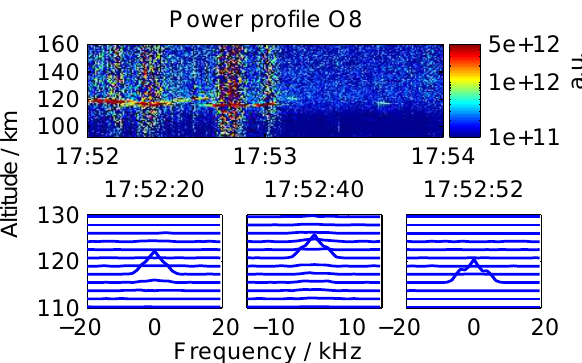
Fig. 7. Same as Fig. 2 for heating cycle O8